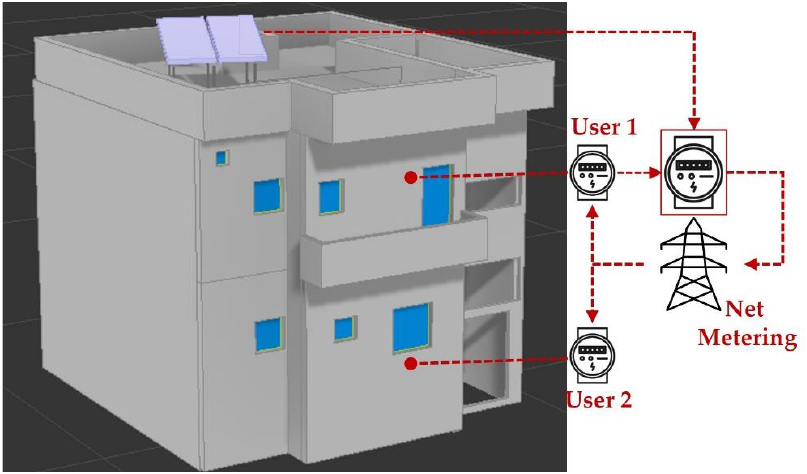
Figure 8. An imaginative vision of a collective PV production (net metering scheme). The model was generated by the author using 3ds